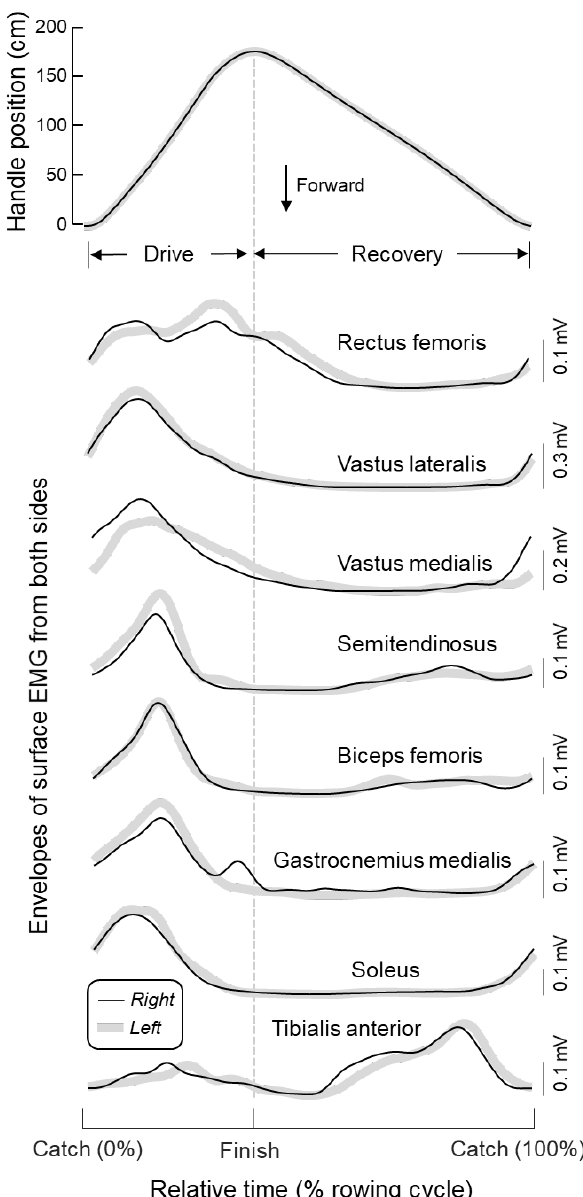
Figure 2. Average (thin black line) and standard deviation (thick gray line) values for the handle position across rowing cycles are shown on top for a single participant. The envelope of surface EMGs averaged across rowing cycles is shown separately for each of the eight muscles tested in the left (thin black line) and right (thick grey line) body sides. From top to bottom: Rectus femoris, vastus lateralis and medialis, semitendinosus, biceps femoris, gastrocnemius medialis, soleus and tibialis anterior. Time is represented in relative units, with respect to the rowing cycle, with the vertical dashed line indicating the finish instant. The average standard deviation for EMG envelopes was remarkably small, ranging from 19.5 to 51.5 µV across muscles and body sides.